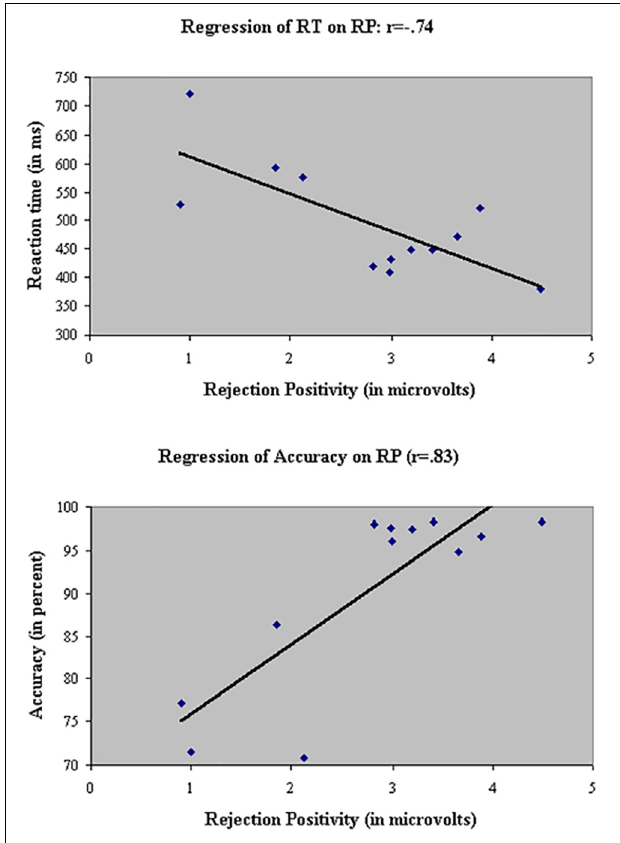
FIGURE 13 | Linear regressions of the two behavioral measures, RT (Top) and accuracy (Bottom), on RP to the initial distractor. As RP increased, participants responded faster ( r = –0.74) and more accurately ( r =